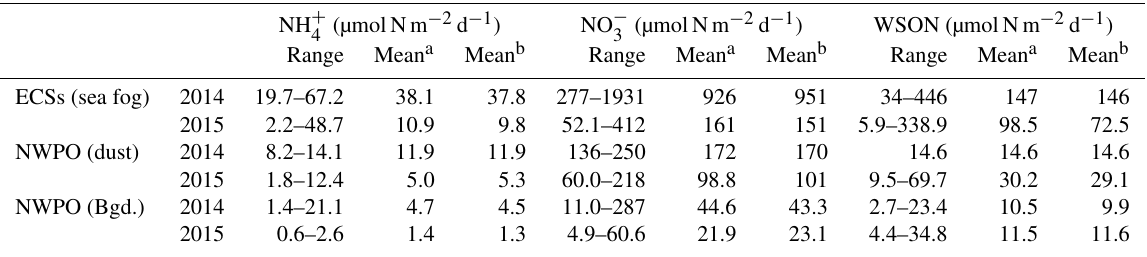
Figure 7. Scatter plots of aerosol δ 15 N-RN against the WSON / RN ratio in the (a) ECSs, (b) dust aerosol in the NWPO and (c) background aerosol in the NWPO. The green bar indicates the sources of anthropogenic, terrestrial and oceanic δ 15 N-NH + sources of terrestrial and anthropogenic δ 15 N-WSON, and the red bar indicates the δ 15 N-DON in SSW. Table 3. Dry deposition fluxes of water-soluble nitrogen